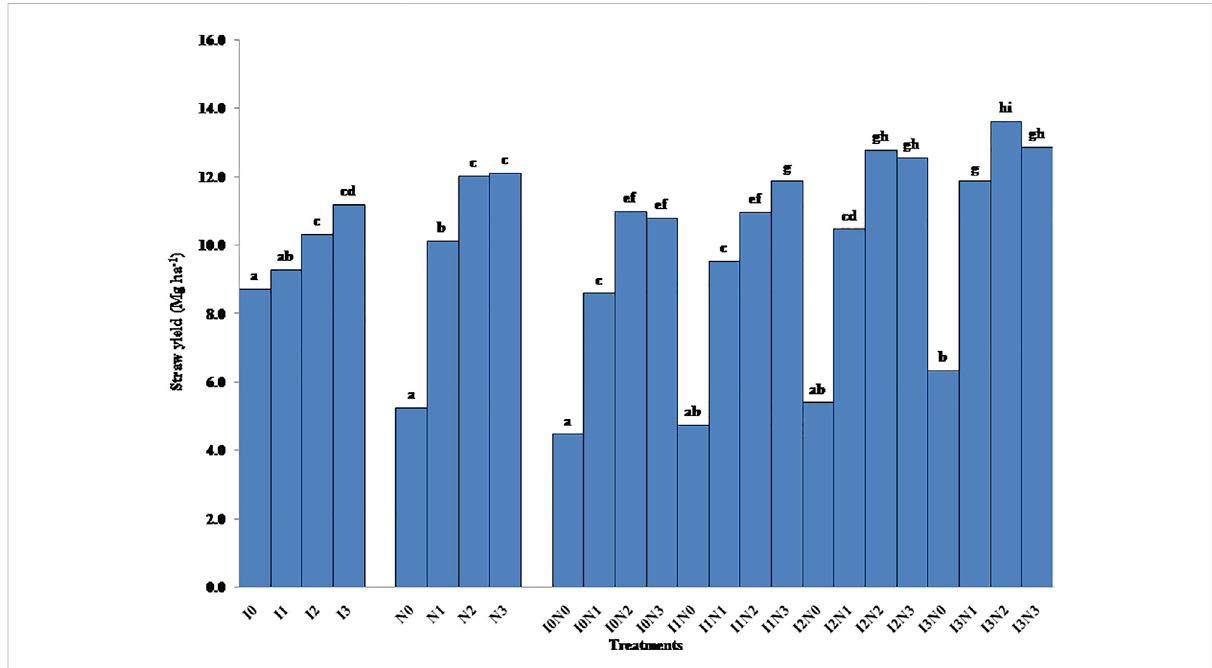
FIGURE 4 Effectofirrigationandnitrogenlevelsonthestraw yieldunderzero-tilledwheatcropoftheTeraiagro-ecologicalzoneineasternIndia(pooled analysis) (means of similar lowercase letters are not signi fi cant at p < 0.05 based on